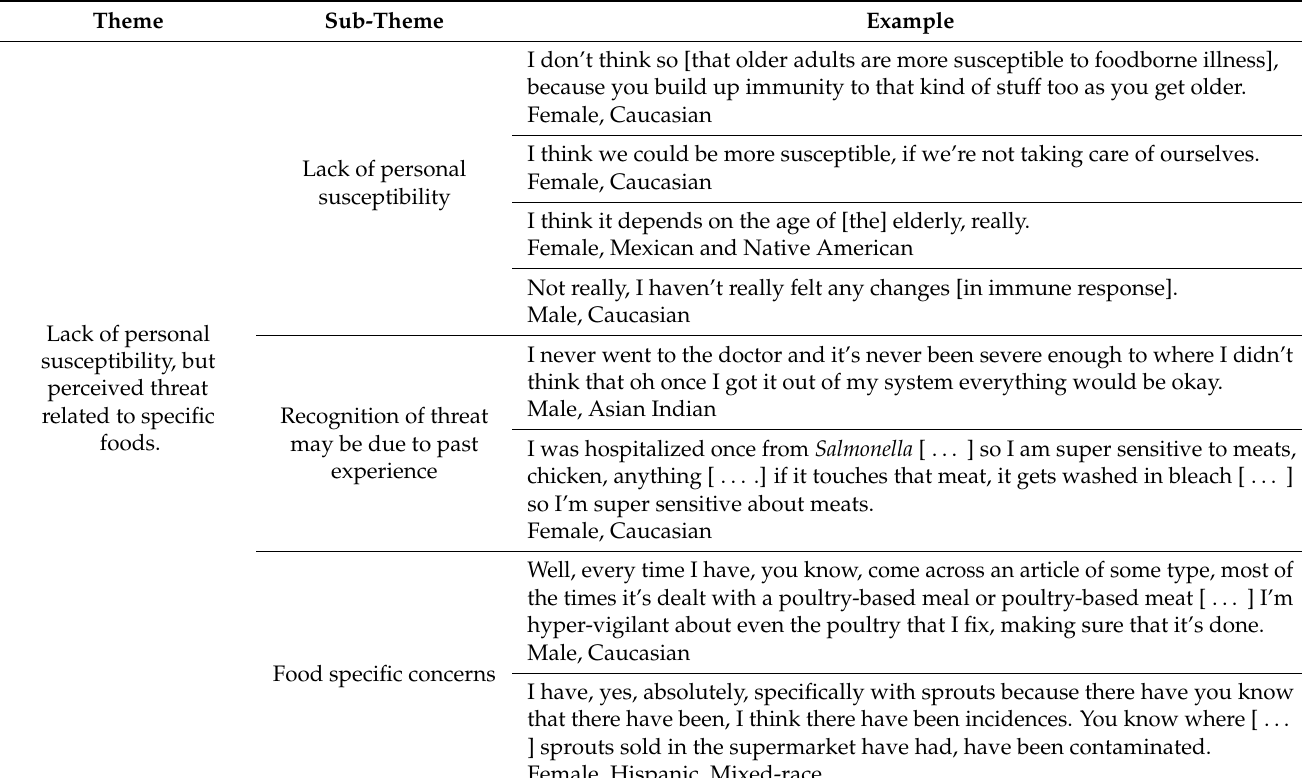
Table 5. Supporting quotes from thematic analysis of the focus group discussions related to the Health Belief Model construct, perceived